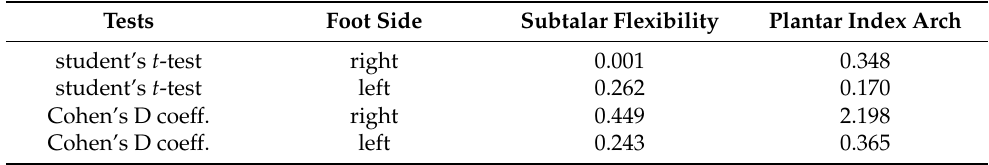
Table 6. p value (student’s t -test) * and Cohen’s D coefficient ** for parameters at EV2 comparing the results of the two groups.